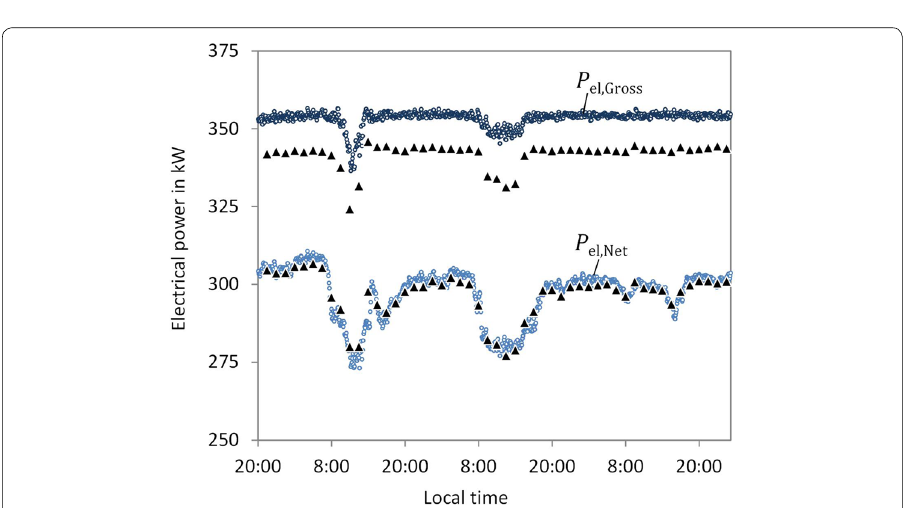
Fig. 13 Gross and net power output—comparison of modeled and real plant data for Plant data for 48 h